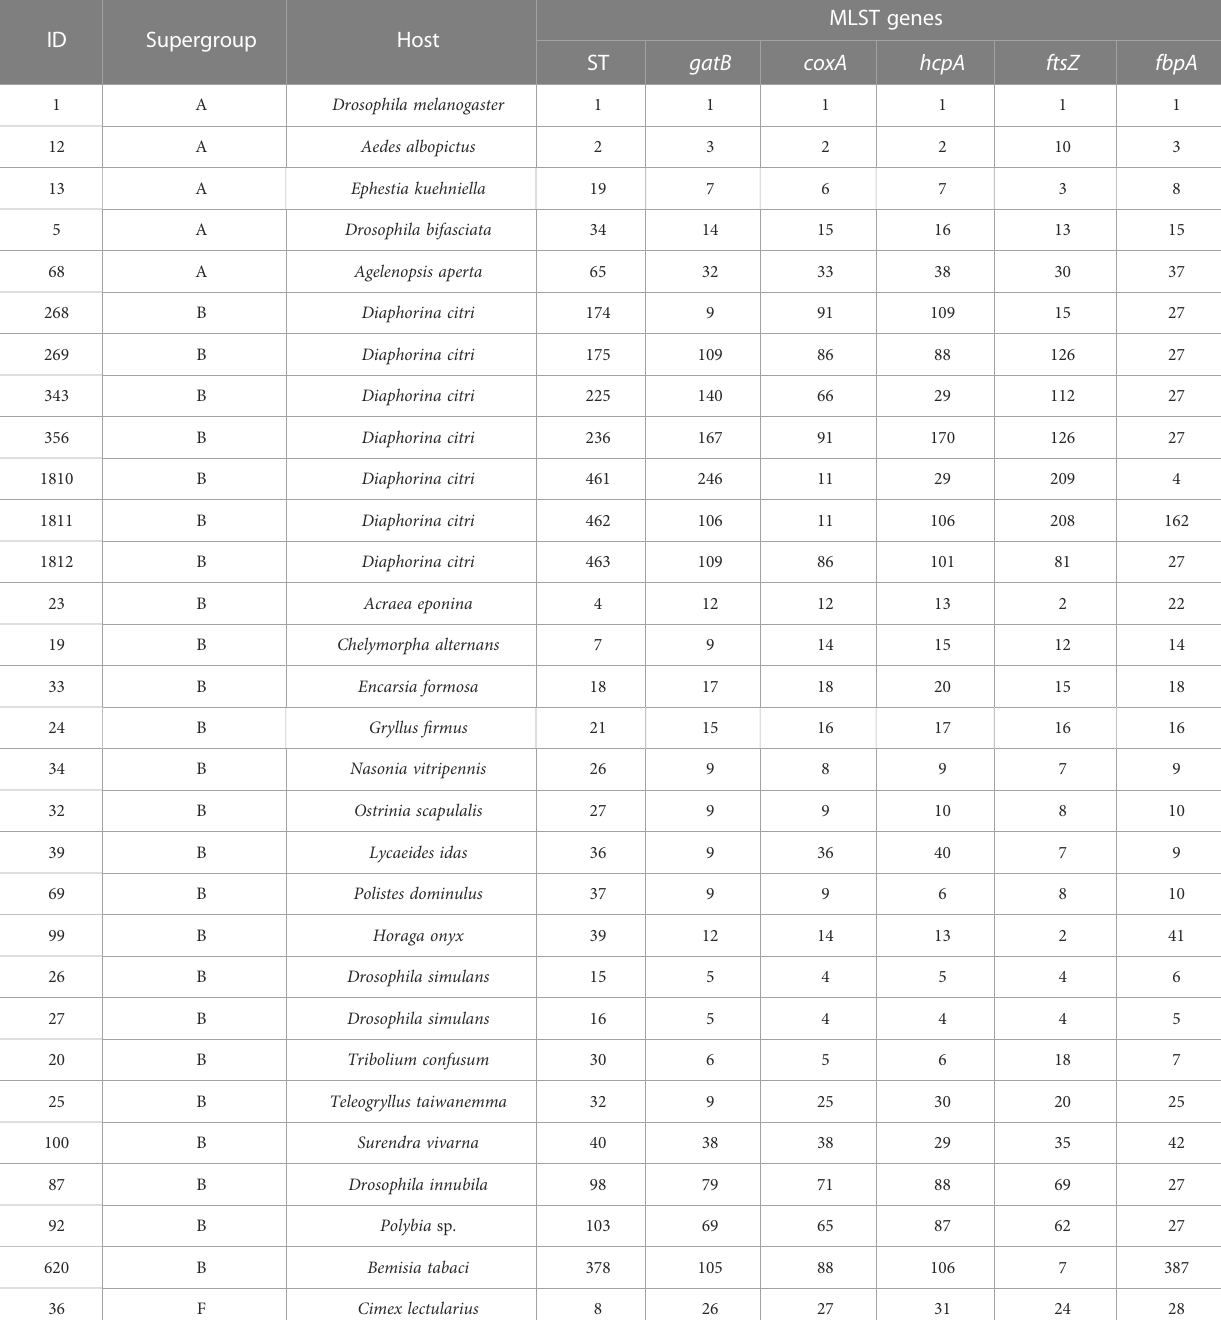
TABLE 5 The reference sequences of Wolbachia MLST genes used in the phylogenetic analysis.